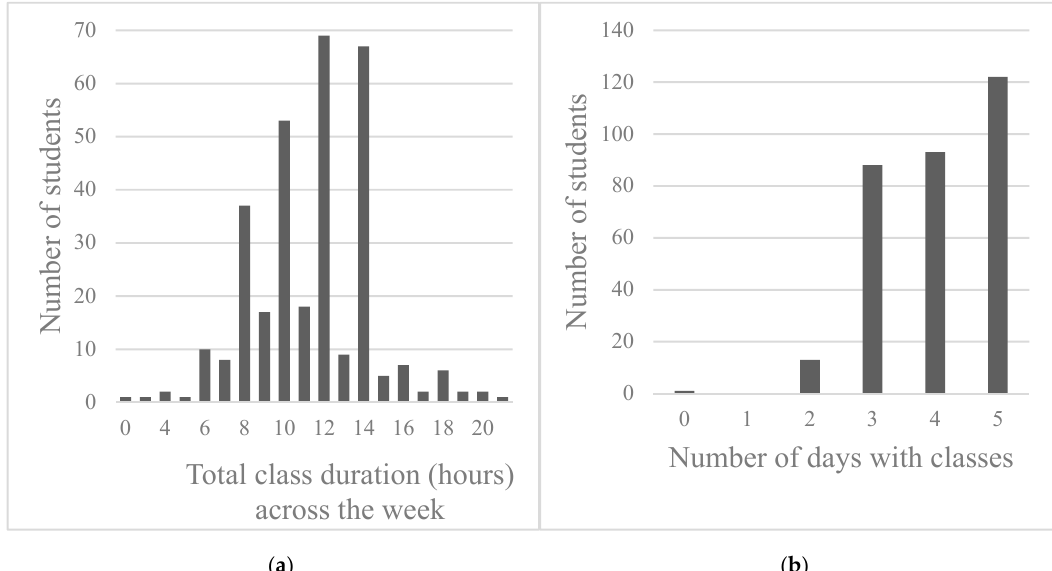
Figure 1. ( a ) Number of students across the total duration of classes (hours) scheduled across the week; ( b ) Number of students across the total number of class days scheduled across the week. Class duration (hours) was rounded up. For example, 1.5 h is rounded up to 2.0 h for illustrative purposes.